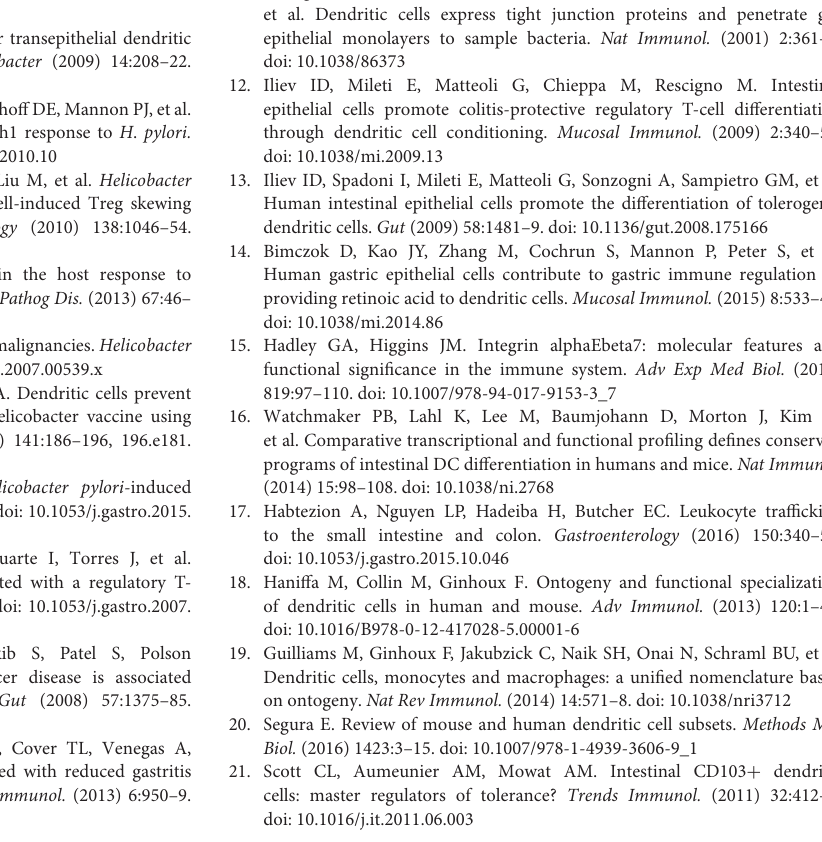
Supplemental Figure 1 | Coating of glass surfaces with rh E-cadherin. Untreated or poly-L lysine-coated wells of a glass bottom 96 well plate were incubated with recombinant human E-cadherin (1 µ g/mL) in PBS for 60min. Following a blocking step with 10% human serum, and several washes, E-cadherin bound to the plate was detected using an anti-E-cadherin antibody and visualized using an alkaline phosphatase detection system. Left panel: mean absorption (405nm) ± SEM of duplicate wells. Right panel: plate image. Supplemental Figure 2 | Retinoic acid significantly increases expression of CD103, but not E-cadherin in human MoDCs. MoDCs were treated with 100nM RA and surface expression of E-cadherin (left panel, n = 12) and CD103 (right panel, n = 13) were analyzed with flow cytometry. ∗ P ≤ 0.05; unpaired, two-tailed T -test. Supplemental Figure 3 | Strong adhesion of MoDCs to E-cadherin negative AGS cells. Top panel: confocal analysis of an AGS and an HT-29 monolayer shows surface E-cadherin expression (green) by the HT-29, but not by AGS cells. Bottom panel: RA-treated or untreated MoDCs were added to confluent monolayers of AGS or HT-29 cells for 2h. Non-adherent cells were then removed by gentle washing, the remaining cells were collected by trypsinization, and the number of adherent DCs was determined using counting beads and CD11c-labeling of the DCs. Mean ± SEM of three independent experiments. Data were analyzed by ANOVA with Tukey’s post-hoc test. a, b: different letters indicate significantly different values ( P ≤